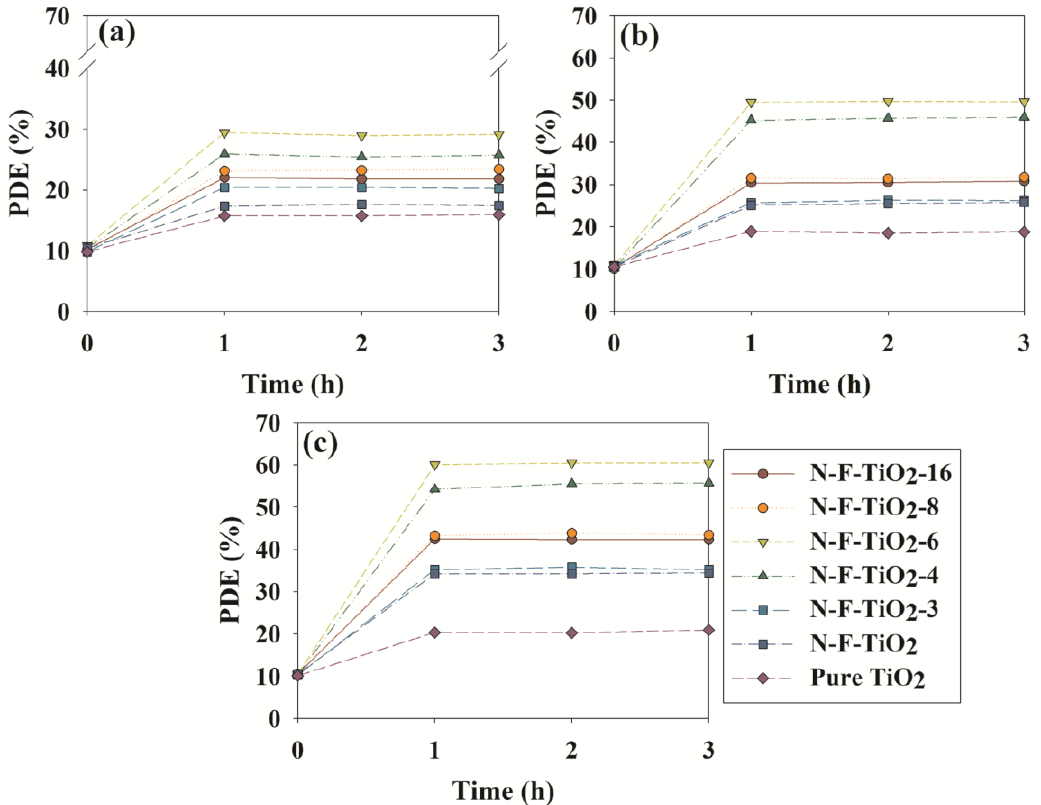
Figure 4. Time-series photocatalytic degradation efficiencies (PDEs, %) of ( a )